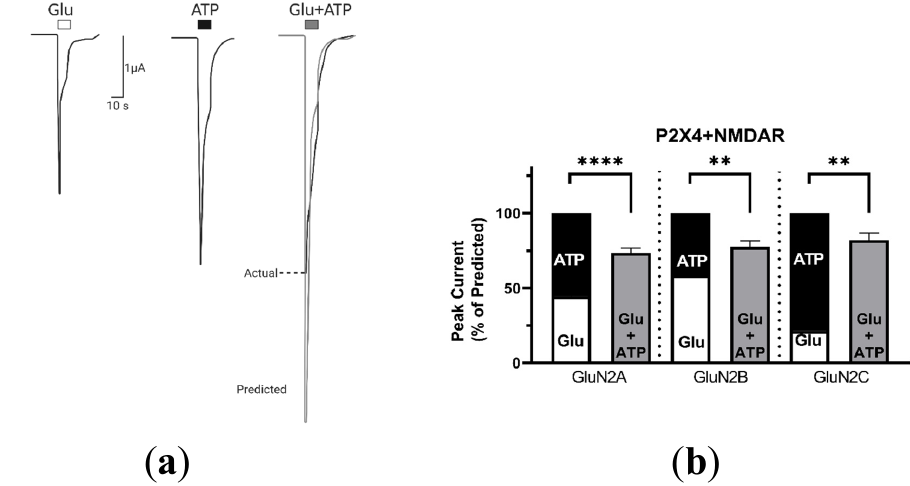
Figure 1. P2X4–NMDAR coactivation produces an inhibited response. ( a ) Representative currents recorded from an individual oocyte coexpressing P2X4 and GluN2B-containing NMDARs responding to: Glutamate (Glu, 2 µM ), ATP (5 µM), or Glu and ATP (2 µM and 5 µM, respectively). The predicted additive response (grey line) is calculated as the sum of the separate Glu and ATP induced currents. ( b ) Bar graphs comparing the predicted and actual responses obtained from coapplication of agonists for P2X4 and NMDARs containing GluN2A ( n = 9), GluN2B ( n = 9), or GluN2C ( n = 10), normalized to the sum of the separate Glu and ATP responses for each oocyte. The data are expressed as mean ± SEM; Statistical analysis performed using paired t-test ** p < 0.01, **** p < 0.0001. P2X: Purinergic P2X receptors; NMDAR: N-methyl-D-aspartate receptor.